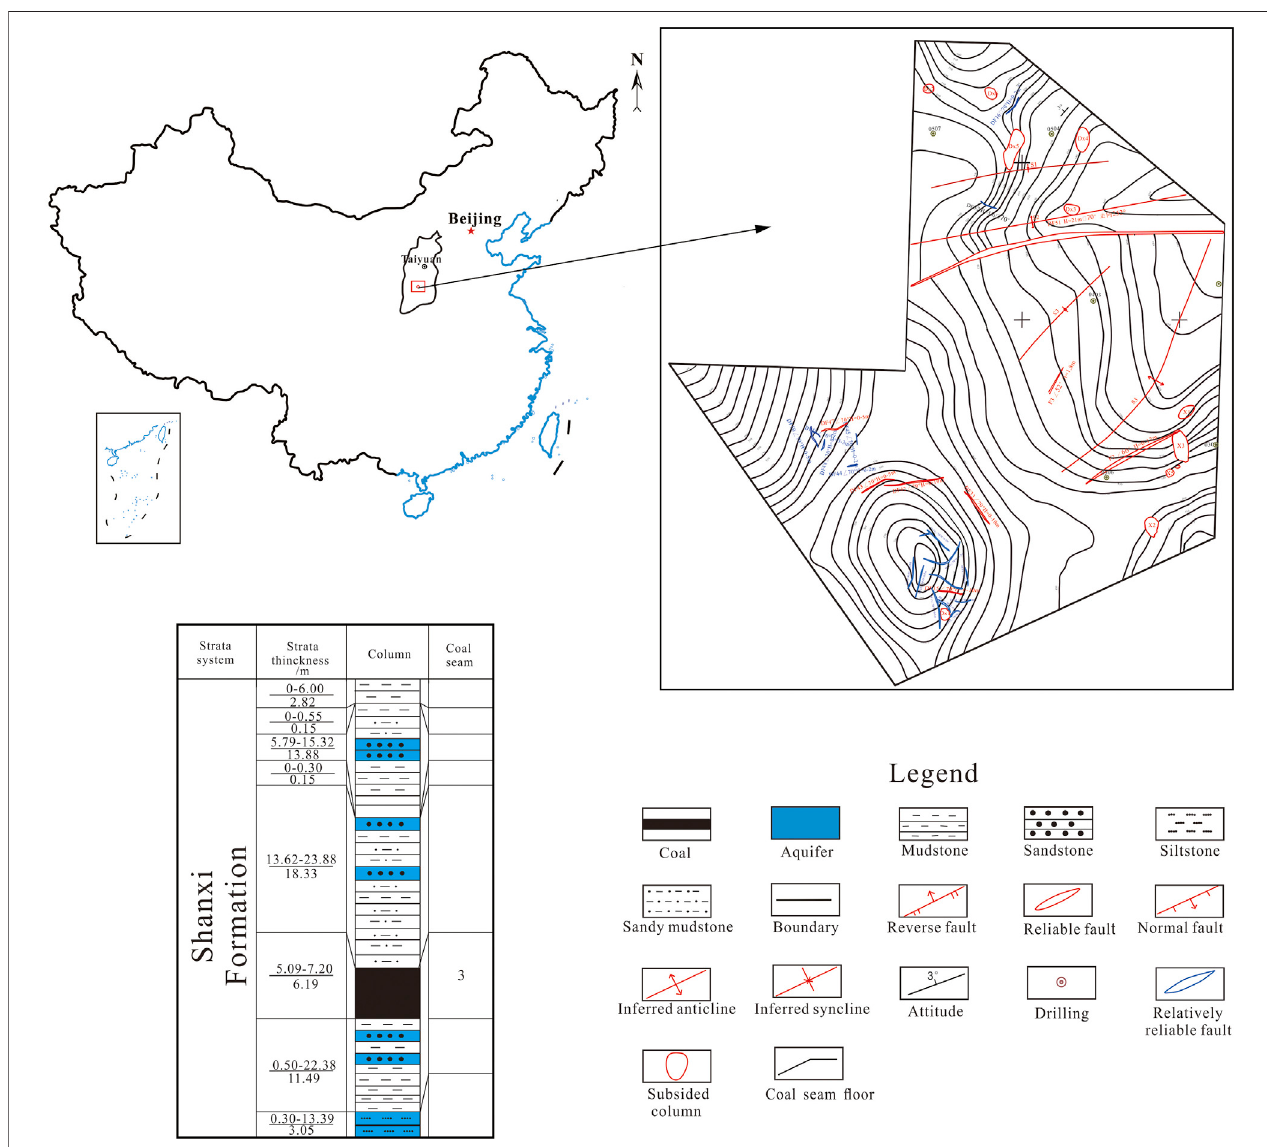
FIGURE 1 | Location and geological map of the study